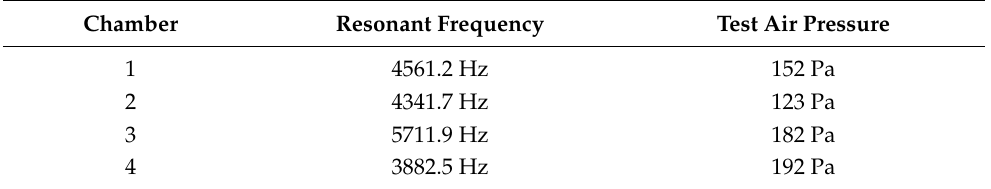
Table 4. Test pressure of four microparticle vacuum chambers on the same wafer before getter is activated.